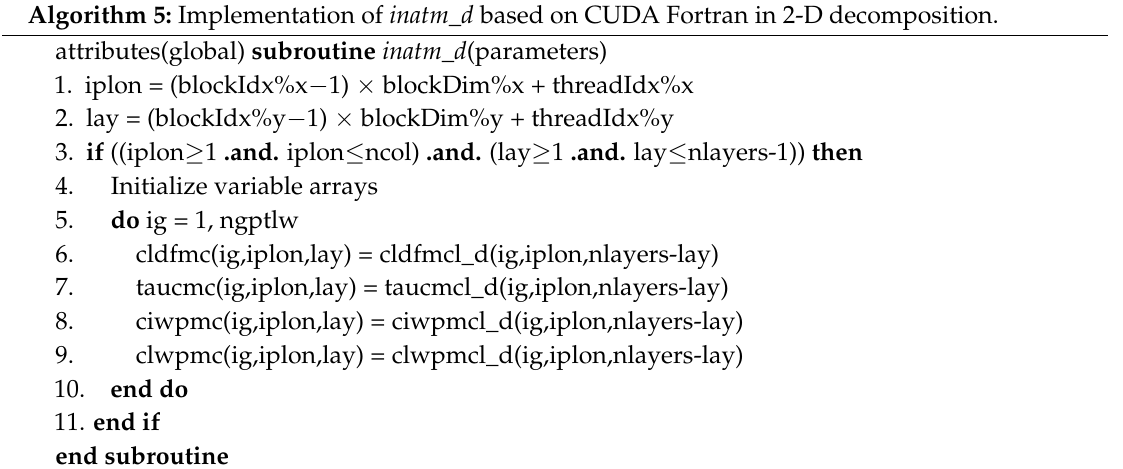
Algorithm 5: Implementation of inatm_d based on CUDA Fortran in 2-D decomposition. attributes(global) subroutine inatm_d